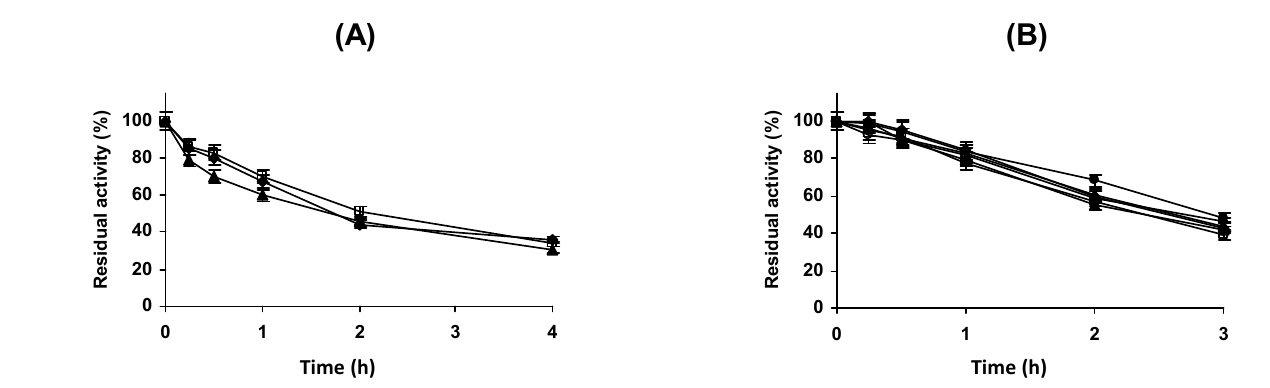
Figure 3. Effect of the concentration of free r Aae UPO stability. The experiments were performed at pH 7 ( A ) 50 mM sodium phosphate at 57.0 or ( B ) 50 mM Tris at 57.5 ◦ C. Other specifications can be found in the Methods section. Full circles: dilution